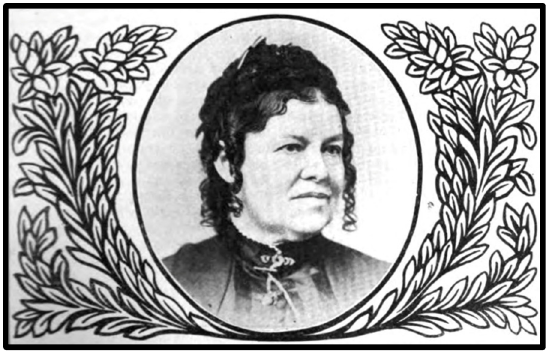
Figure 1. Marilla Baker Ingalls, 1827–1902 [4].